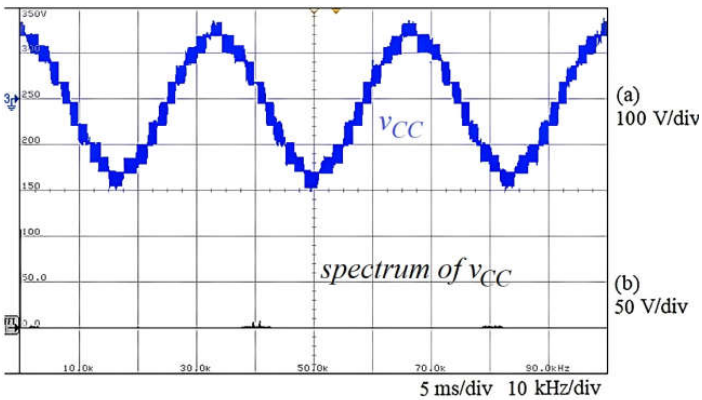
Figure 12. Voltage waveform and frequency spectrum for the AC port voltage of the CC: ( a ) voltage waveform; ( b ) frequency spectrum.